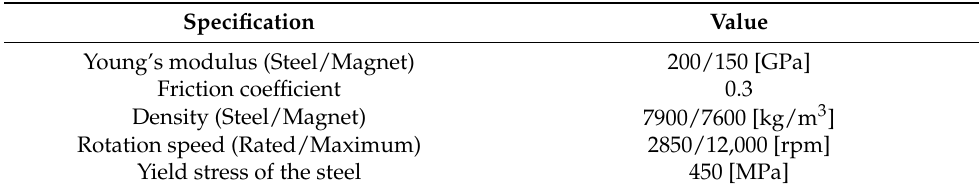
Table 4. Conditions and specifications for the mechanical stress analysis.